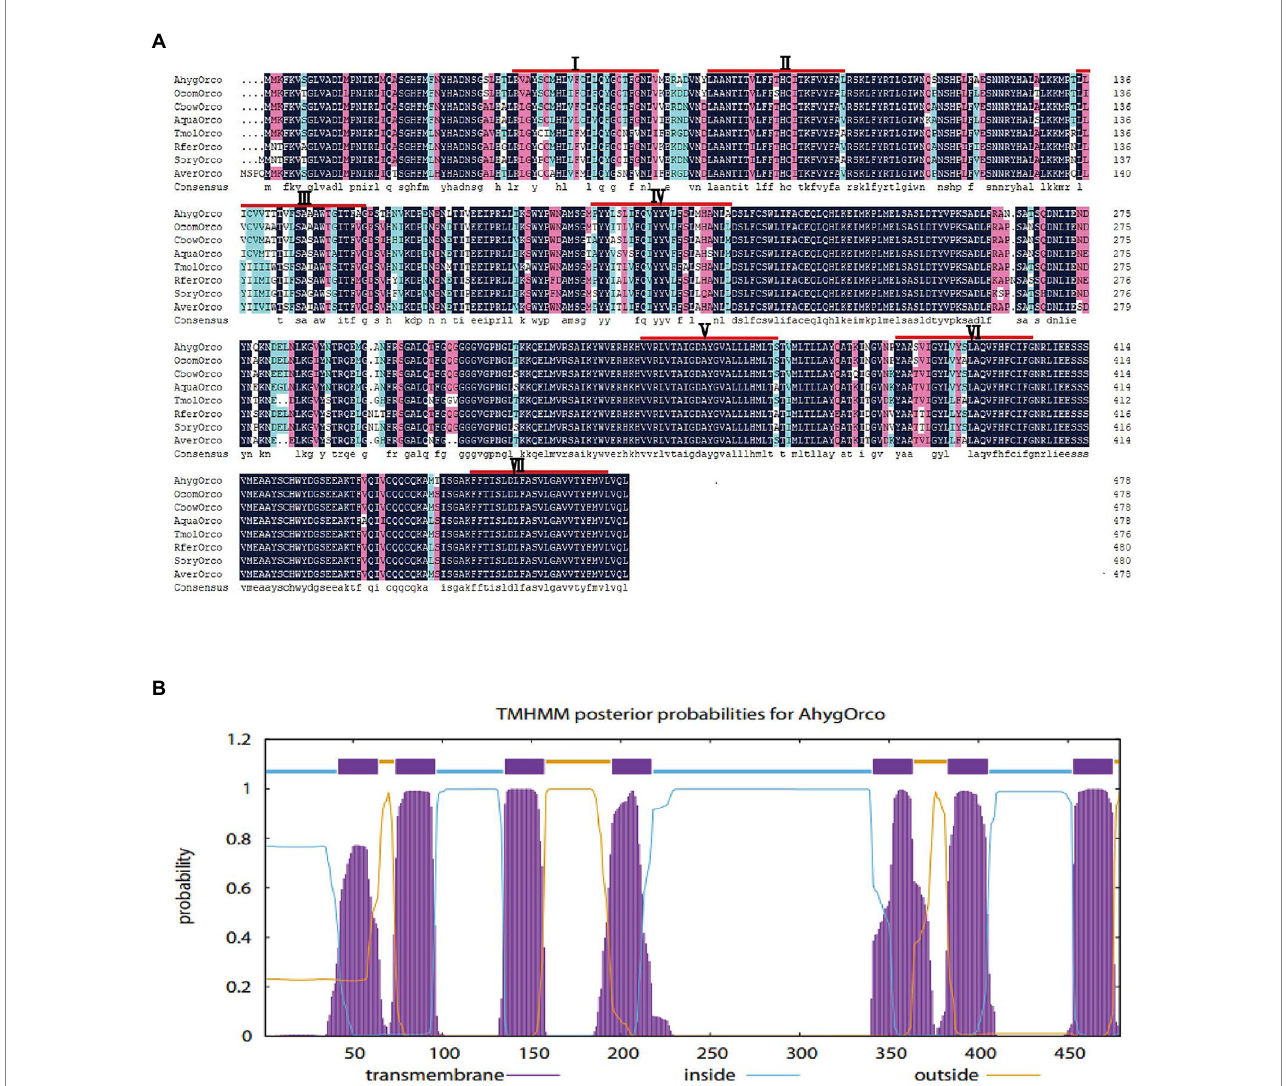
FIGURE 2 (A) Multiple sequence alignment of the AhygOrco -deduced amino acid sequence with the other Orco from seven Coleoptera insects (Ocom: Ophraella communa , Cbow: Colaphellus bowringi , Aqua: Ambrostoma quadriimpressum , Tmol: Tenebrio molitor , Rfer: Rhynchophorus ferrugineus , Sory: Sitophilus oryzae , Aver: Asbolus verrucosus ). The transmembrane domains I–VII are indicated by red lines. (B) Prediction of transmembrane helices in the encoded amino acid